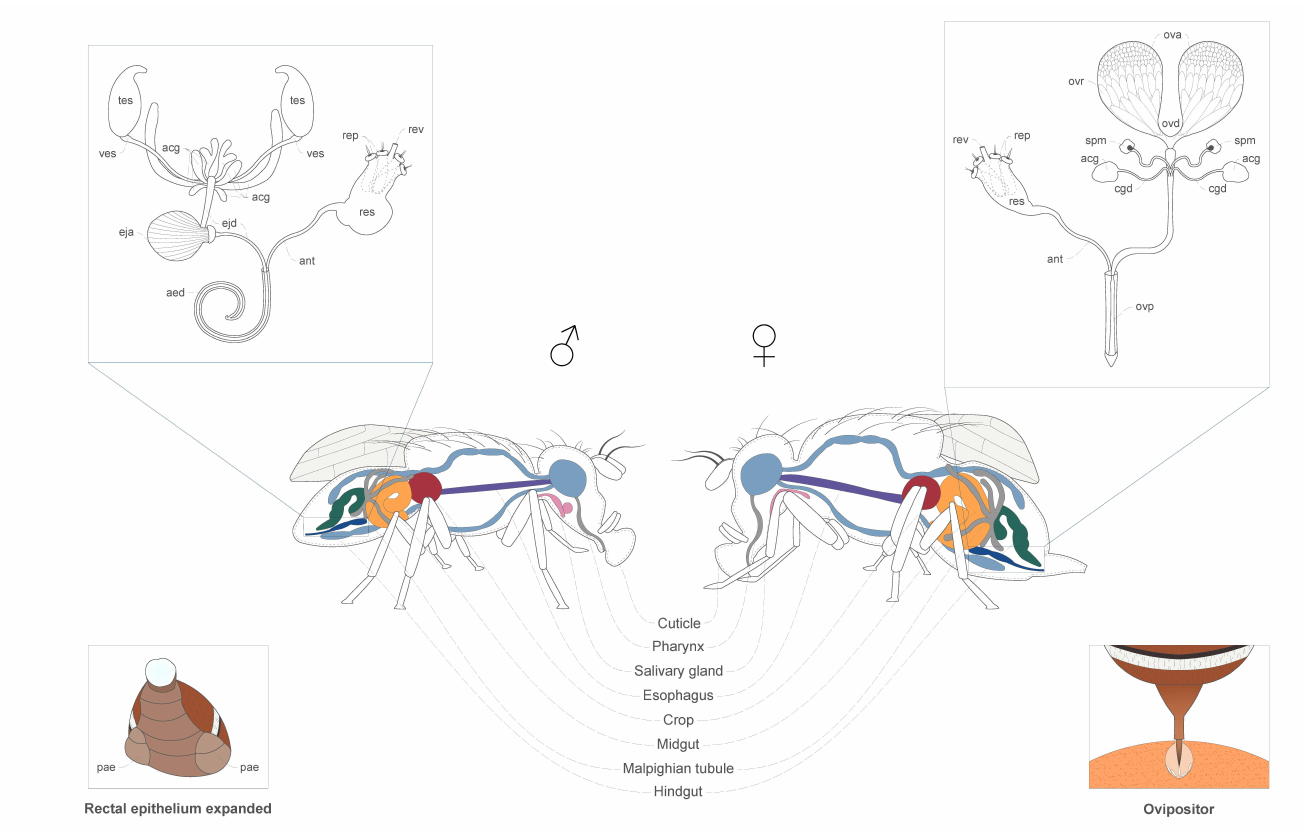
Figure 3. Tissues involved in semiochemicals’ production in tephritids. Diagrammatic representation of a male (left) and female (right) generalized tephritid showing the tissues/body compartments involved in pheromone production. Reproductive tracts and rectum are shown in upper left (male) and right (female) boxes. Bottom left and right boxes show the abdomen of a calling male, showing the expanded rectal epithelium (pae, pleural abdominal expansion), and the ovipositor of a female. Abbreviations: Male reproductive system: tes (testes), ves (vas deferens), acg (accessory glands), ejd (ejaculatory duct), eja (ejaculatory apodeme), aed (aedeagus). Female reproductive system: ova (ovaries), ovr (ovariole), ovd (oviduct), spm (spermathecae), acg (accessory glands), cgd (colleterial gland duct), ovp (ovipositor). Rectum: rev (rectal valve), rep (rectal papilla), res (reservoir containing pheromone), ant (anal